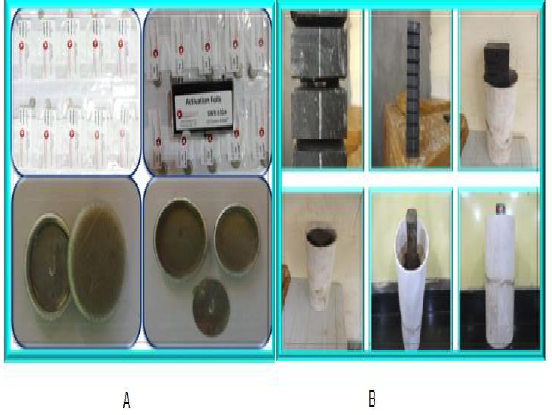
Fig. 2: Fermi Age for Graphite material using the activation of Indium foil